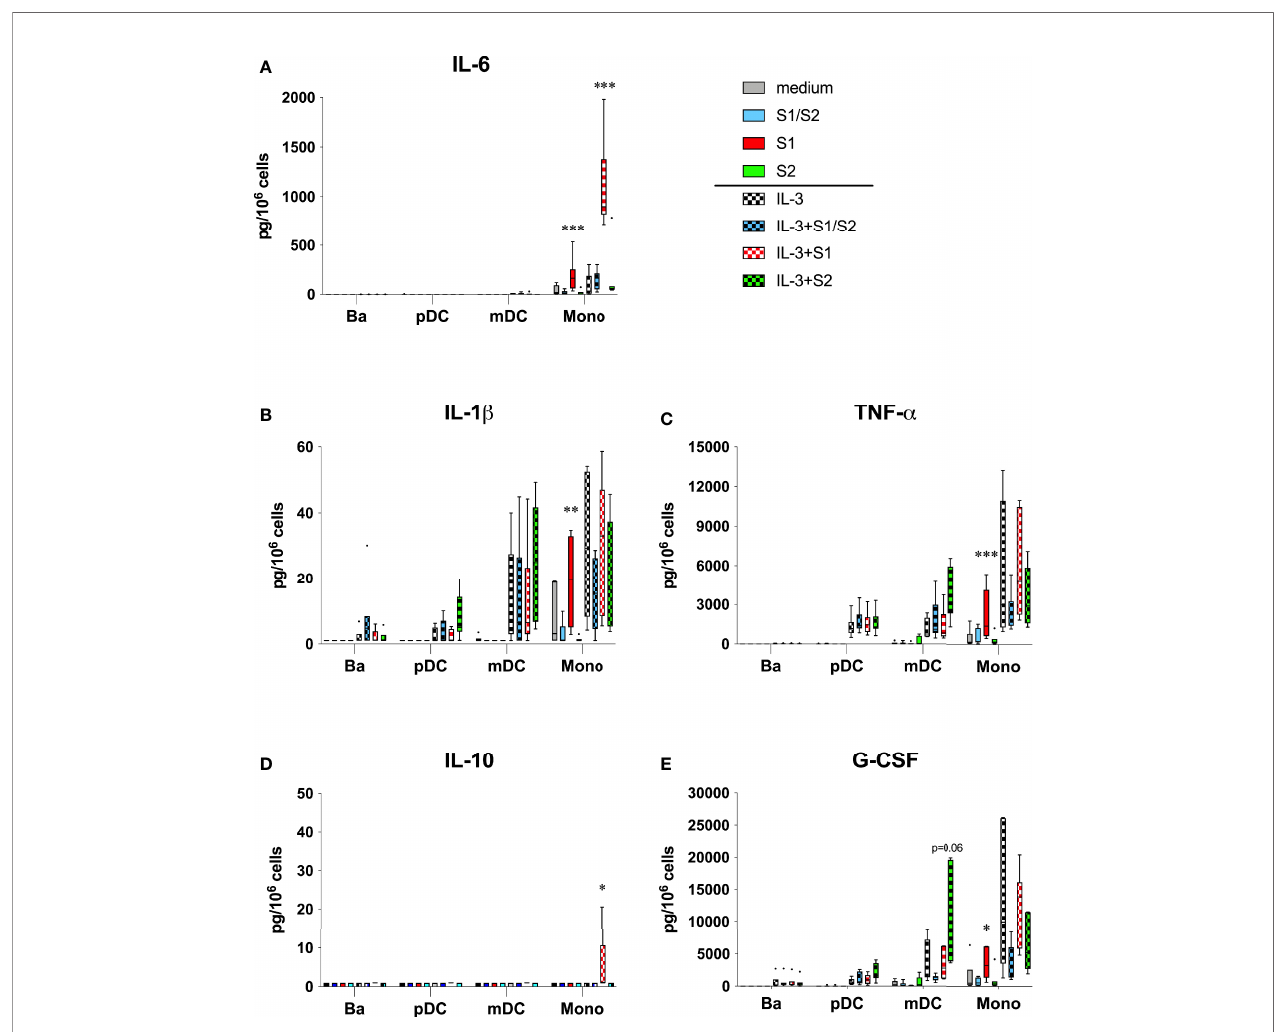
FIGURE 1 | (A – E) Cytokines linked to COVID-19 are induced by the S1 subunit of the SARS-CoV-2 spike protein. Subunit components of the SARS-CoV-2 spike protein were passively absorbed onto polystyrene culture wells, as described in the Materials & Methods section. After overnight incubation at 4 ˚ C followed with 3x washes, basophils (Ba), pDC, mDC, and monocytes (Mono) were then cultured as indicated in medium alone or with IL-3 added to 10 ng/ml. After 20h incubation, cell- free supernatants were harvested for analysis of the indicated cytokines using multiplex analysis. Box-Whisker plots (Tukey ’ s method) represent results from different donor cell preparations (n=7). Responses to spike protein components were tested for signi fi cance by comparing to medium/IL-3 controls. ***P<0.001, **P<0.01,